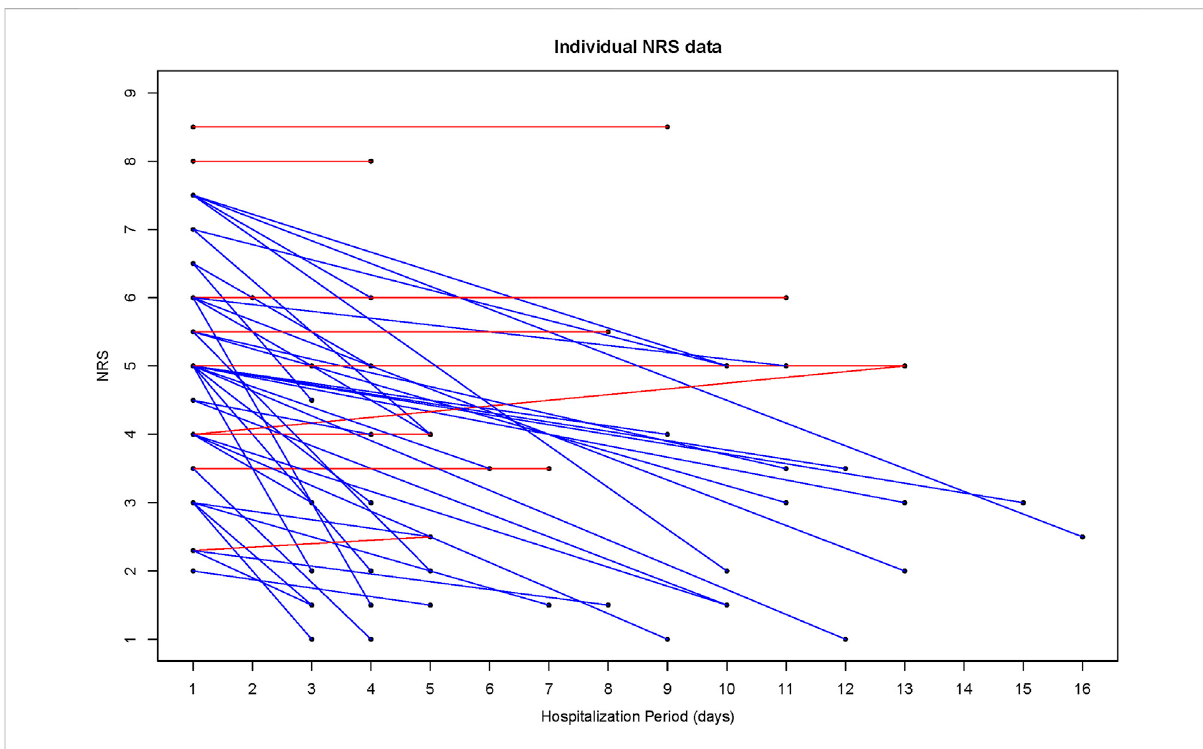
FIGURE 2 Individual data of the numeric rating scale